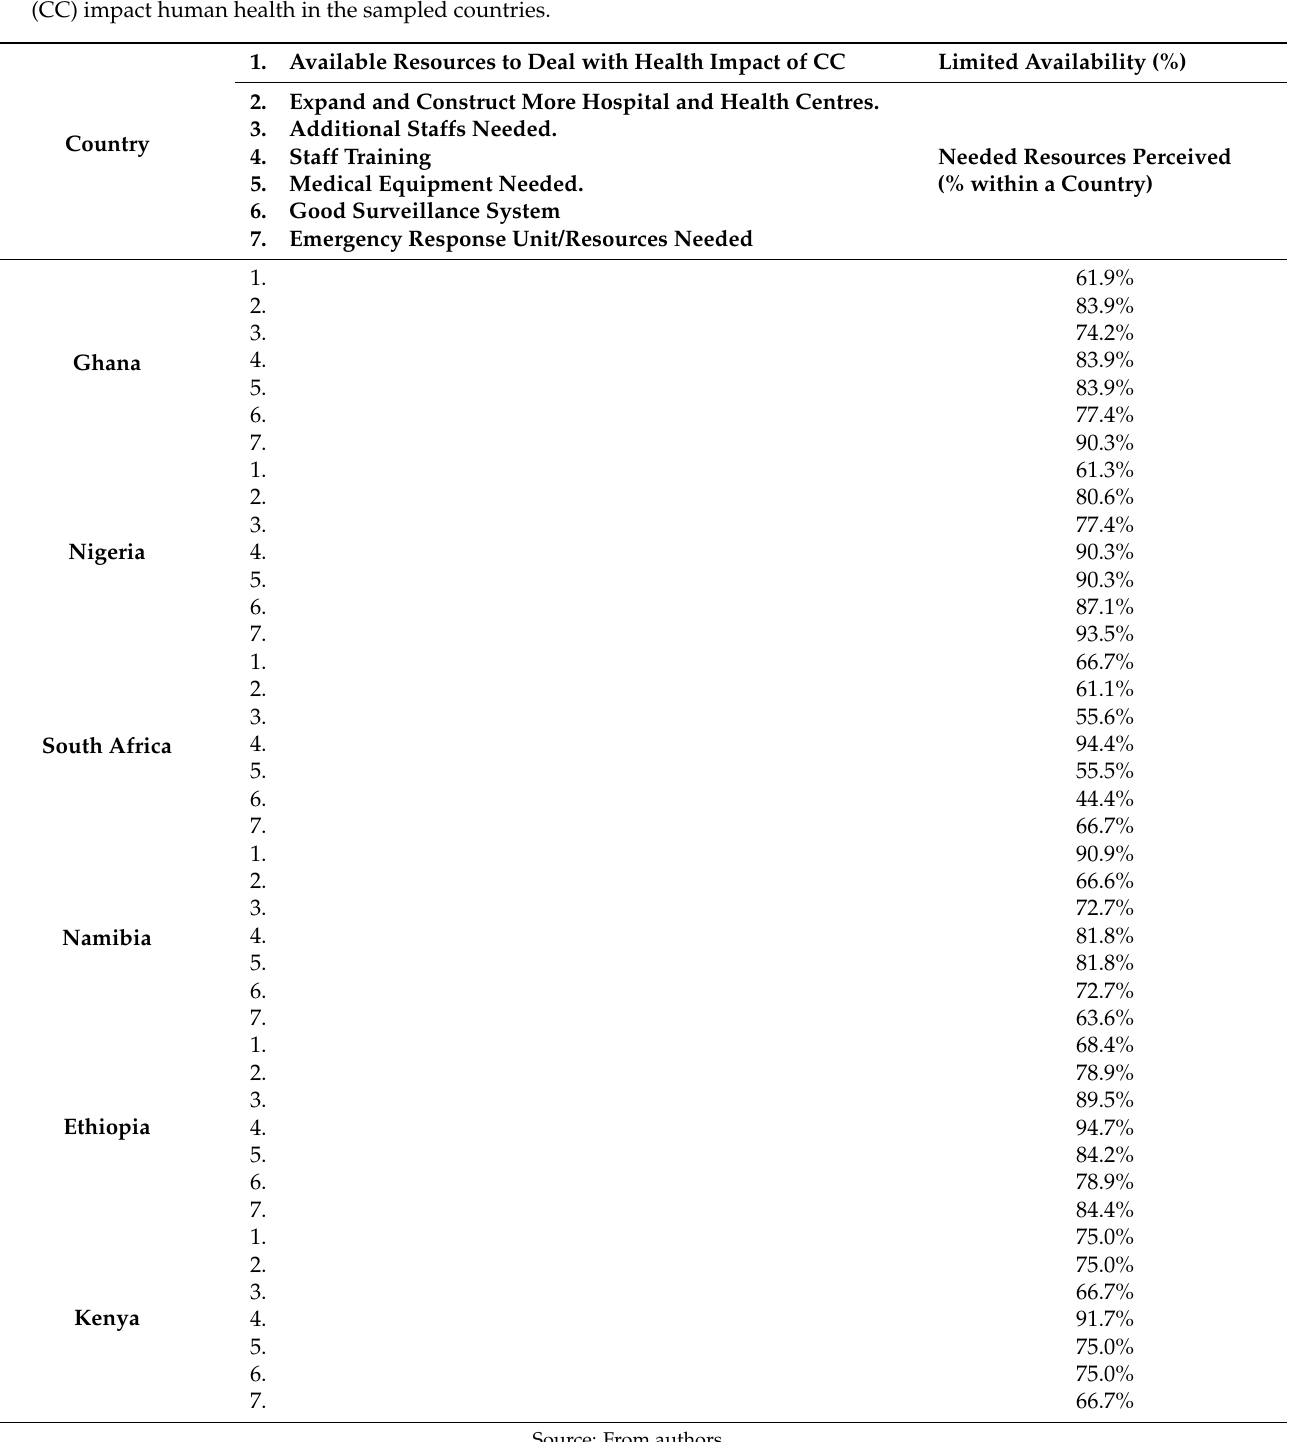
Table 10. Respondents’ perceptions about the health system’s available resources and those needed to curb climate change (CC) impact human health in the sampled